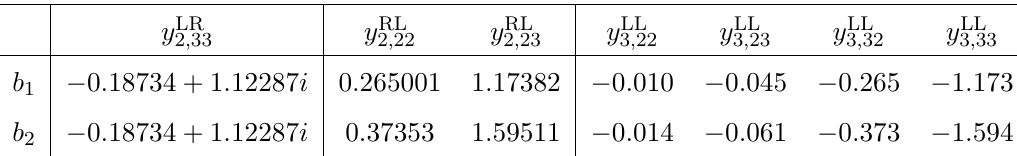
Table 2 . Non-zero Yukawa couplings for two benchmark points in a two-leptoquark model allowing for an explanation for the flavour anomalies [100, 101]. Benchmarks include an R 2 leptoquark (with m R = 1 . 3 TeV) and an S 3 leptoquark (with m S = 2 TeV). Point b 1 corresponds to the best fit 2 3 value and b 2 is chosen inside the 2 σ region returned by the